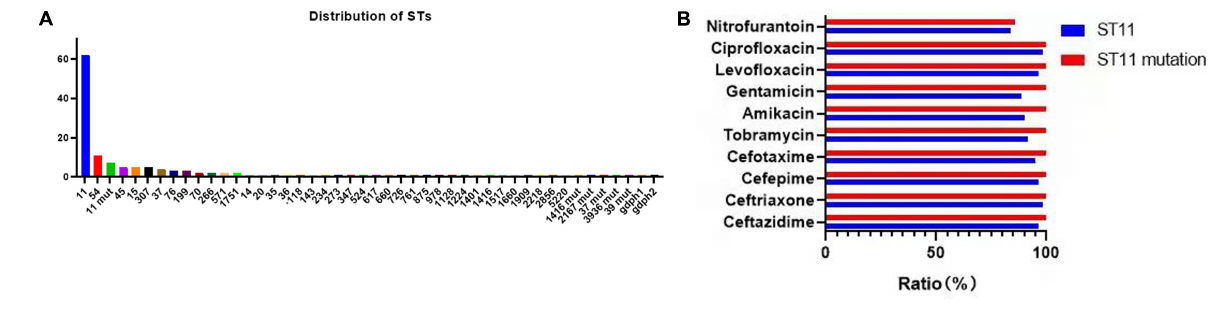
FIGURE 3 | The MLST results of CR-KP. (A) The distribution characteristics of STs. The x- and y-axes represents different STs and the number of ST isolates, respectively. (B) The differences in antibacterial profiles between ST 11 and ST 11-mutation. The x- and y-axes represents rate of antibacterial resistance and different antibacterials, respectively. TABLE 3 | Association between genotype, phenotype and STS.